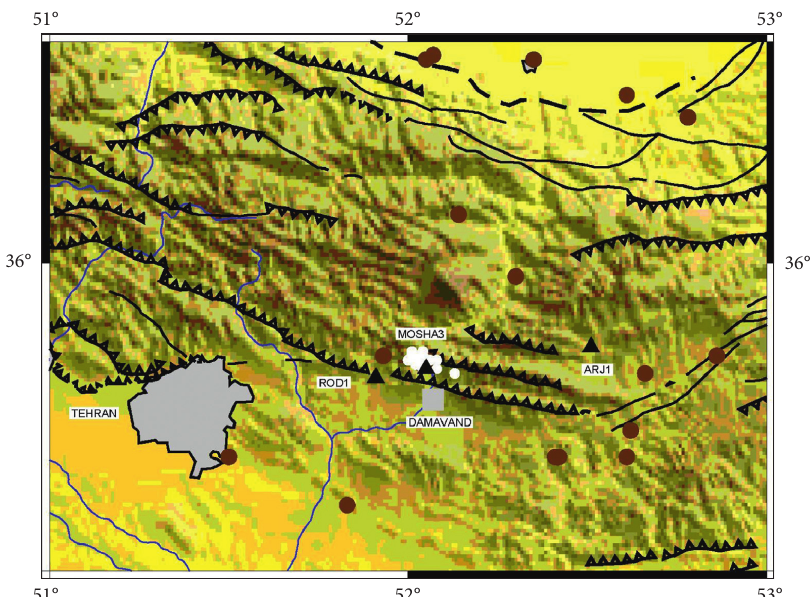
Figure 1: Representation of regionalseismicity (from 2006 to2020) across the Mosha 2020earthquake epicentral area. EarthquakesMn ≥ 4.0 are illustrated inbrown circles, the main event and the following aftershocks Mn ≥ 2.5 inwhite circles, andaccelerographic stationsin blacktriangles.